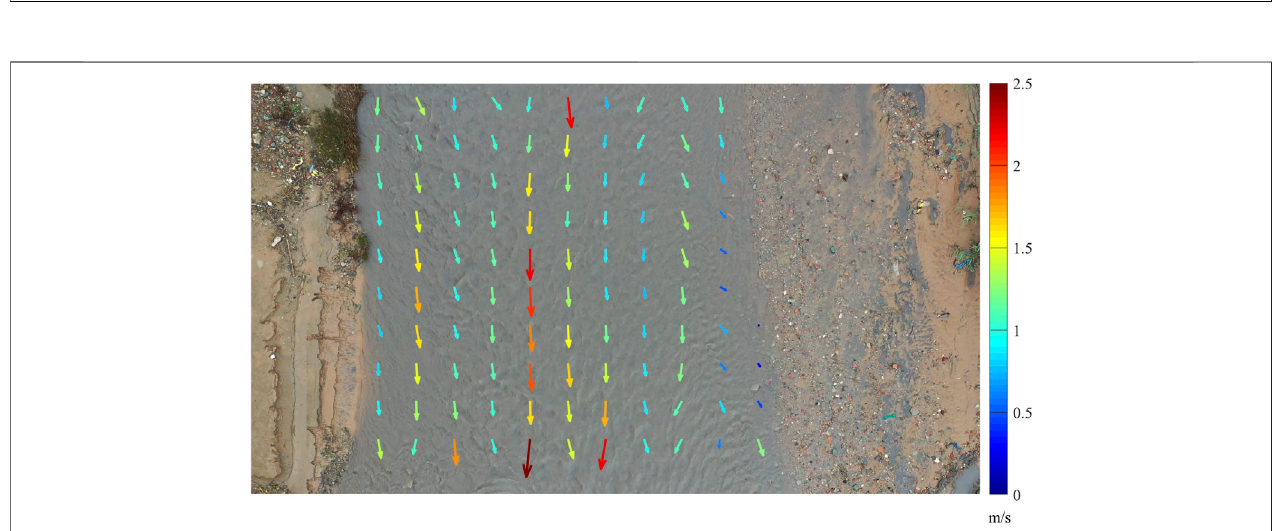
FIGURE 9 | Velocity distribution derived from the Kuye River surface based on UAV video using two-dimensional STIV. The color and length indicate magnitude of the velocity. Grid spacing of vectors is 0.67 m.